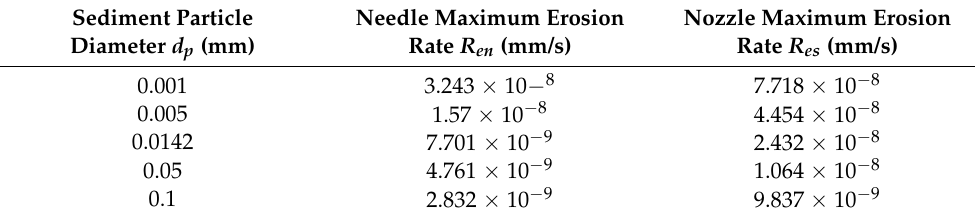
Table 4. Maximum erosion rates for different sediment particle